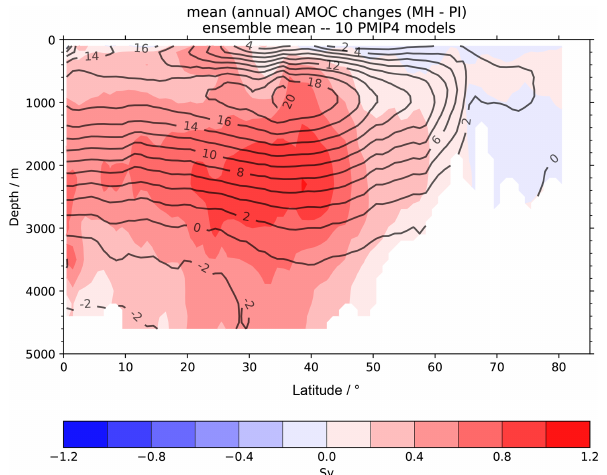
Figure 5. Multi-model mean plots for AMOC spatial structure changes between midHolocene and piControl. Eleven PMIP4 mod- els which performed the midHolocene experiment are used for plot- ting the multi-model means. The overlaid contours (black lines) show AMOC strength in piControl for locating the maximum AMOC.